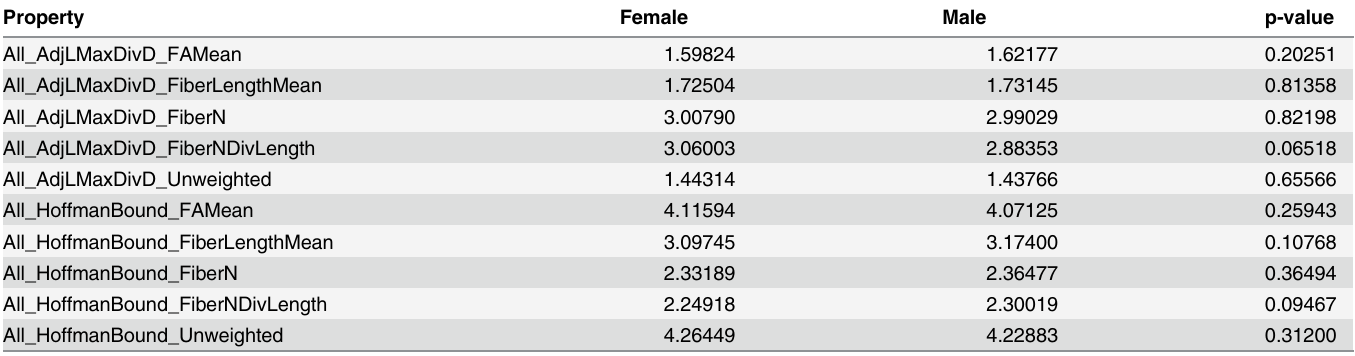
Table 4. The graph-theoretic parameters computed for the 234-vertex graphs. The table contains their arithmetic means in the male and female groups, and the corresponding p-values in round 1 (see the “ Statistical analysis ” subsection). The results of the graph-parameters are defined in the caption of Table 1. Significant differences ( p < 0.01) are denoted with an asterisk in the last column.